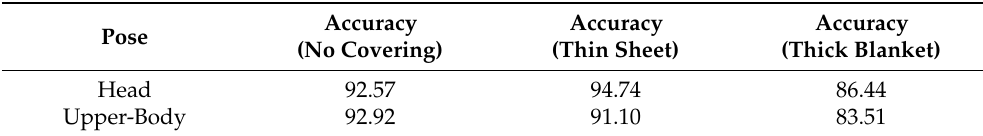
Table 17. Results of the proposed model that was trained on the SLP dataset and tested on the iSP pilot